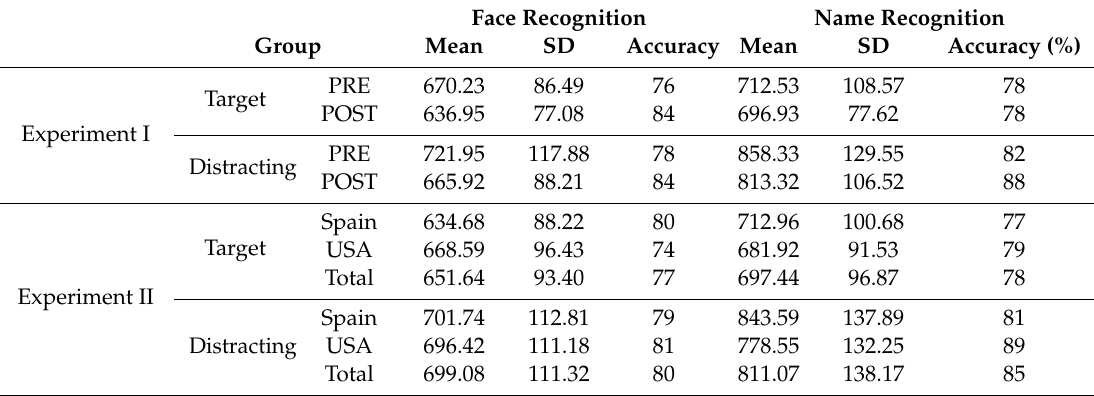
Table 1. Descriptive analysis for both Experiment I and II. SD = standard deviation.